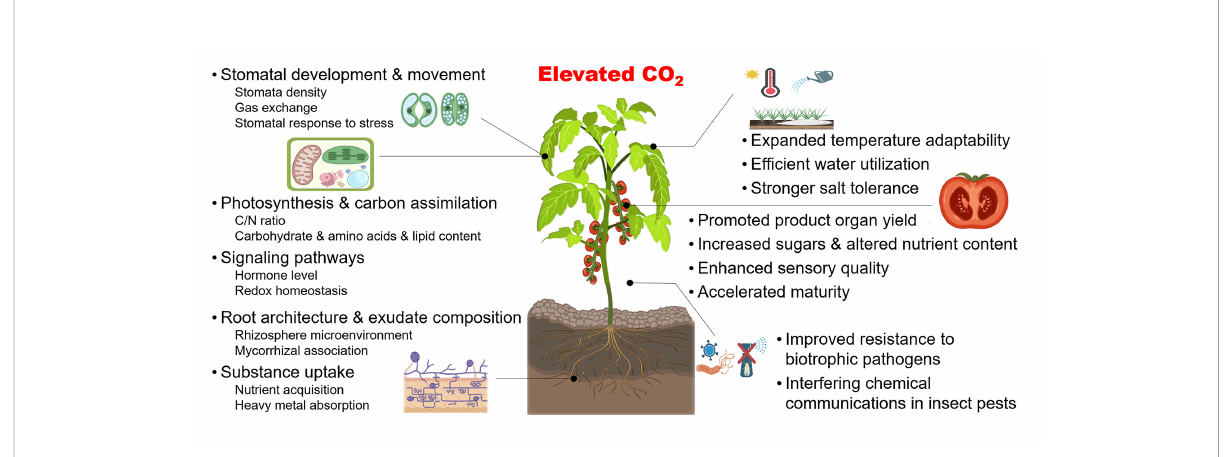
FIGURE 2 Schema illustrating effects of elevated CO 2 on C 3 crops. Elevated CO 2 affects a series of plant biological processes (left) in C 3 crops, including stomatal development and movement, photosynthesis, and carbon assimilation, signaling pathways, root development and exudate composition, and nutrient acquisition. Meanwhile, macro-production effects (right) can also contribute to promoted yield and quality, enhanced tolerance to abiotic stress and improved resistance to several biotic stresses, which invigorate ef fi cient and safe agricultural production to a certain extent. Created with